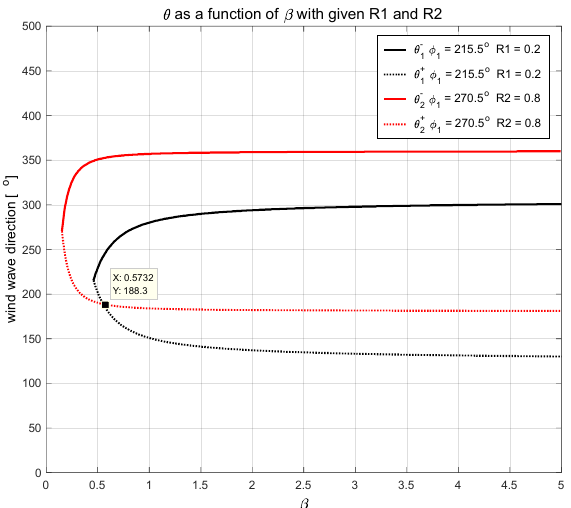
Figure 3. θ as a function of β with given R 1 and R 2 ( β > β min Figure 3. 𝜃 as a function of 𝛽 with given R 1 and R 2 ( 𝛽 > 𝛽 (cid:2923)(cid:2919)(cid:2924) ).